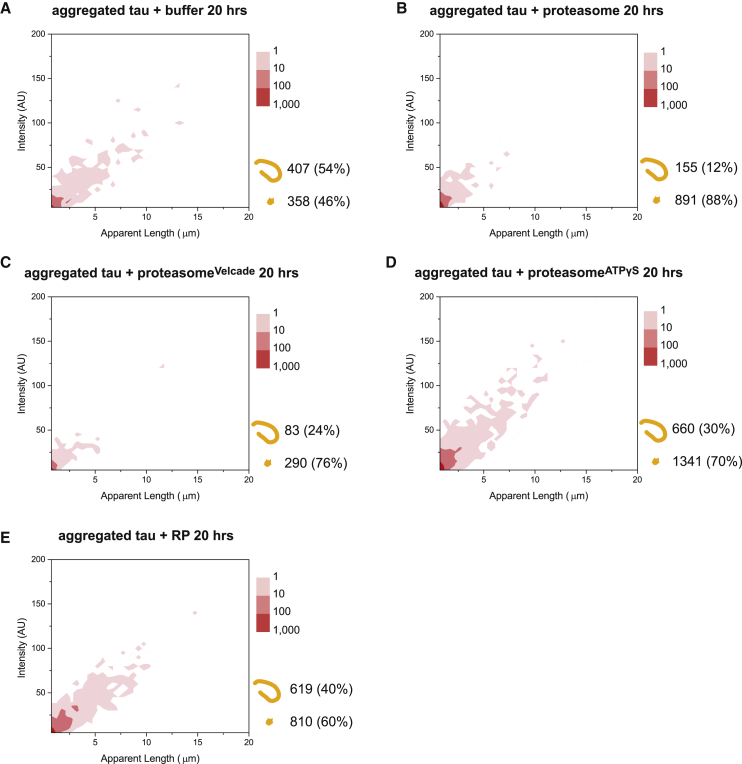
Fragmentation of Fibrils in the Absence of Soluble Tau Proteins(A and B) Aggregated tau samples were centrifuged. The pellet was resuspended in fresh proteasome buffer followed by incubation with (A) buffer control or (B) the proteasome holoenzyme for 20 h and subsequently imaged and presented as described in Figure 1.(C and D) Proteasome holoenzymes pre-treated with (C) Velcade (proteasomeVelcade) or (D) ATPγS (proteasomeATPγS) were subsequently incubated with aggregated tau as in (B).(E) Instead of the holoenzyme, fibrils were also incubated with regulatory particles (RPs) and analyzed as above.Combined results of three independent experiments (n = 3) are shown.